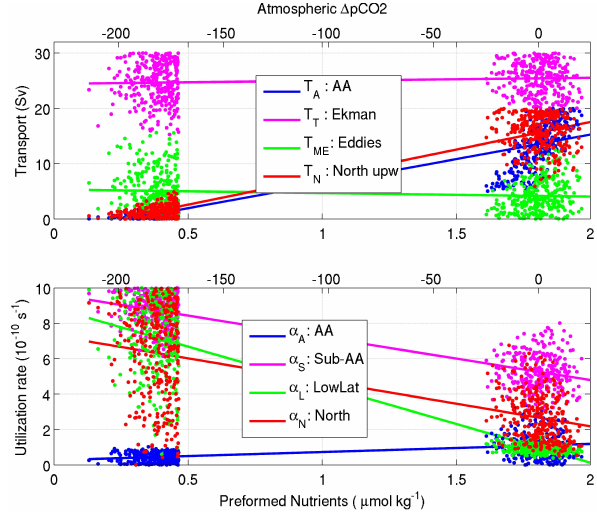
Fig. 7. Same as Fig. 3 but for the model without an equatorial re-